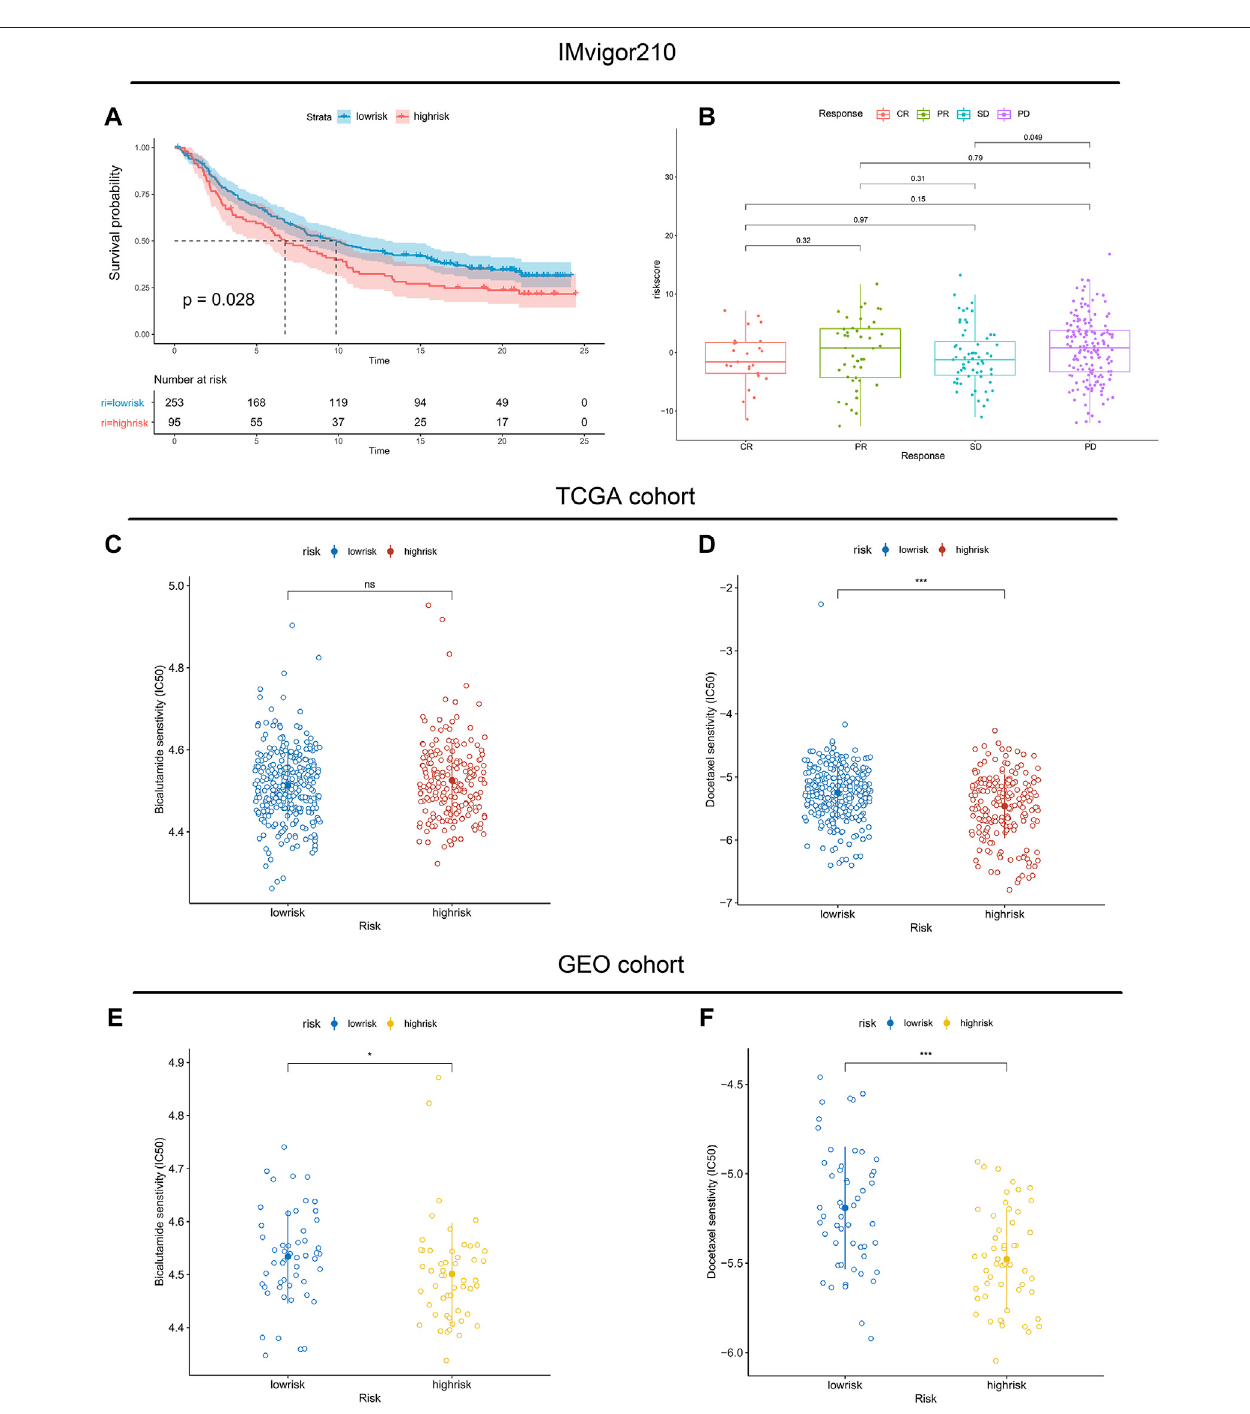
FIGURE 8 | Association between immunotherapy reactivity, drug sensitivity and riskscore. (A) Kaplan – Meier survival curve between high- and low-risk subgroups in the IMvigor210 cohort. (B) The difference in riskscore among patients with different responses to immunotherapy. (C,E) The predicted IC50 values of Bicalutamide in the TCGA cohort and validated GEO cohort. (D,F) The predicted IC50 values of Docetaxel in the TCGA cohort and validated GEO cohort.